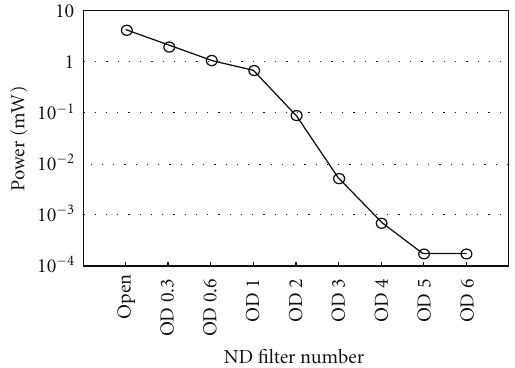
Figure 2: Relationship between the neutral density (ND) filter number and the laser beam